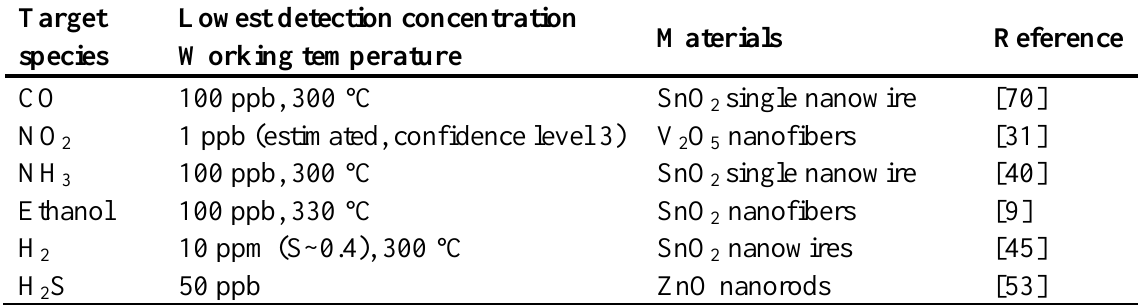
Table 3. The lowest detection concentrations of various gas species measured of metal oxide nanowires gas